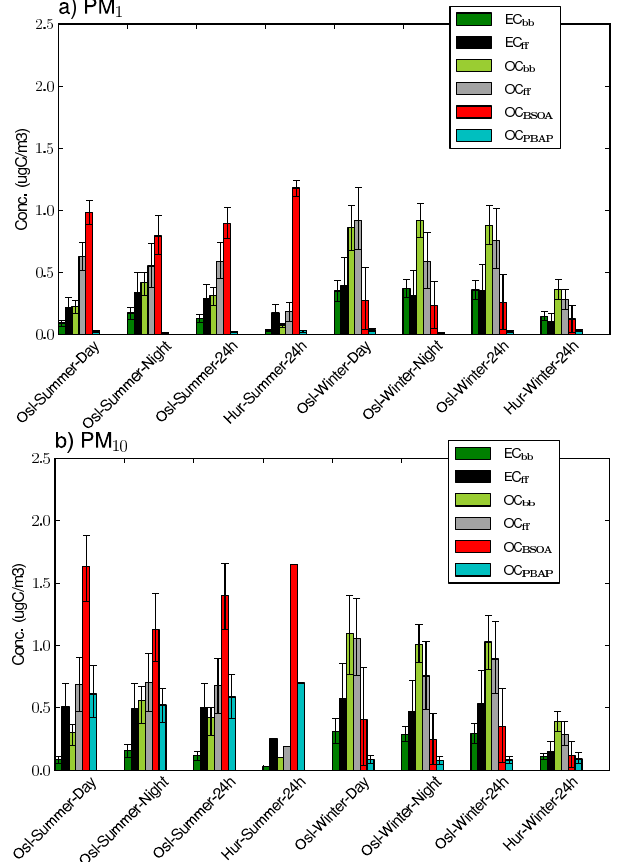
Fig. 1. Best estimate concentrations (µgCm − 3 ) of different car- bonaceous particle fractions for the SORGA samples. Uncertainty bars represent 10 and 90percentiles from LHS